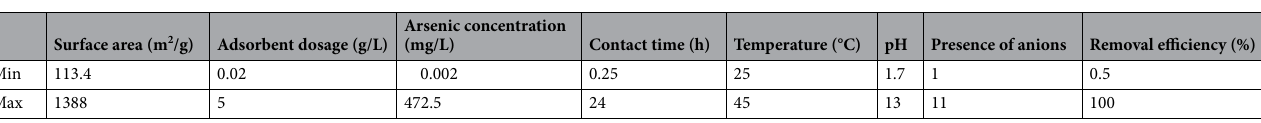
Table 1. Statistical details of the inputs and output parameters collected in this